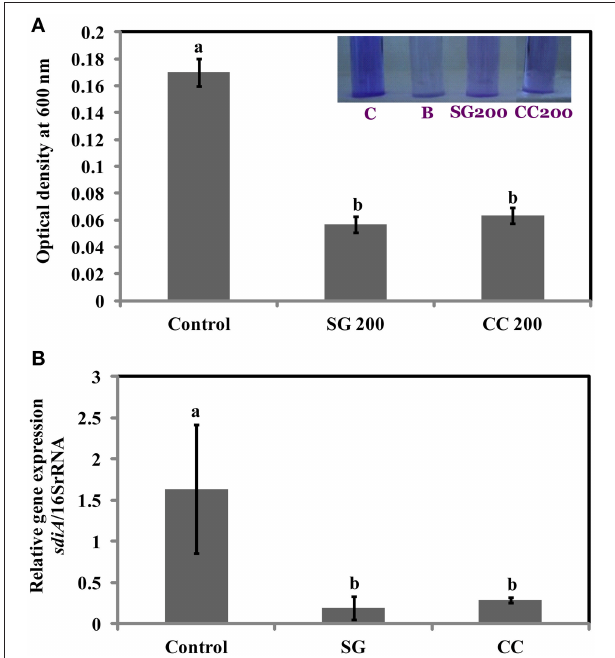
FIGURE 5 | Effect of SWE treatment on biofilm formation of S. Enteritidis. S. Enteritidis culture was statically grown for 24 h at 37 ◦ C in polyvinyl chloride microtitre plates in the presence of 200 µ l/ml SWE (SG or CC). (A) Biofilm formation was quantified by staining with crystal violet and determining the optical density at 600 nm. (B) Effect of SWE on the relative gene expression of sdiA gene (homolog of quorum-sensing regulators LuxR). Values with different superscript letters (Tukey multiple mean comparison) are significantly different (one-way Anova; p < 0.05). Values represent Mean ± Standard deviation from three independent experiments; each experiment had three biological replicates. Picture insert: C, positive control; B, negative control; SG200, 200 µ l/ml SG extract; CC200, 200 µ l/ml CC extract.